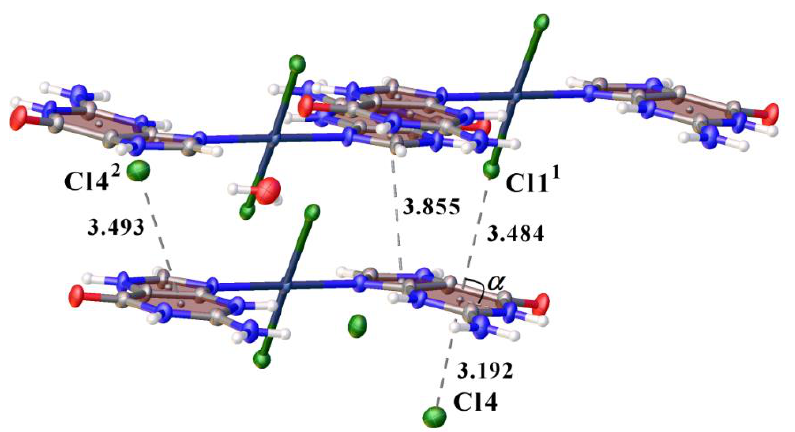
Figure 8. View showing π -stacking and π -halogen interactions with bond lengths between layers in the structure 1